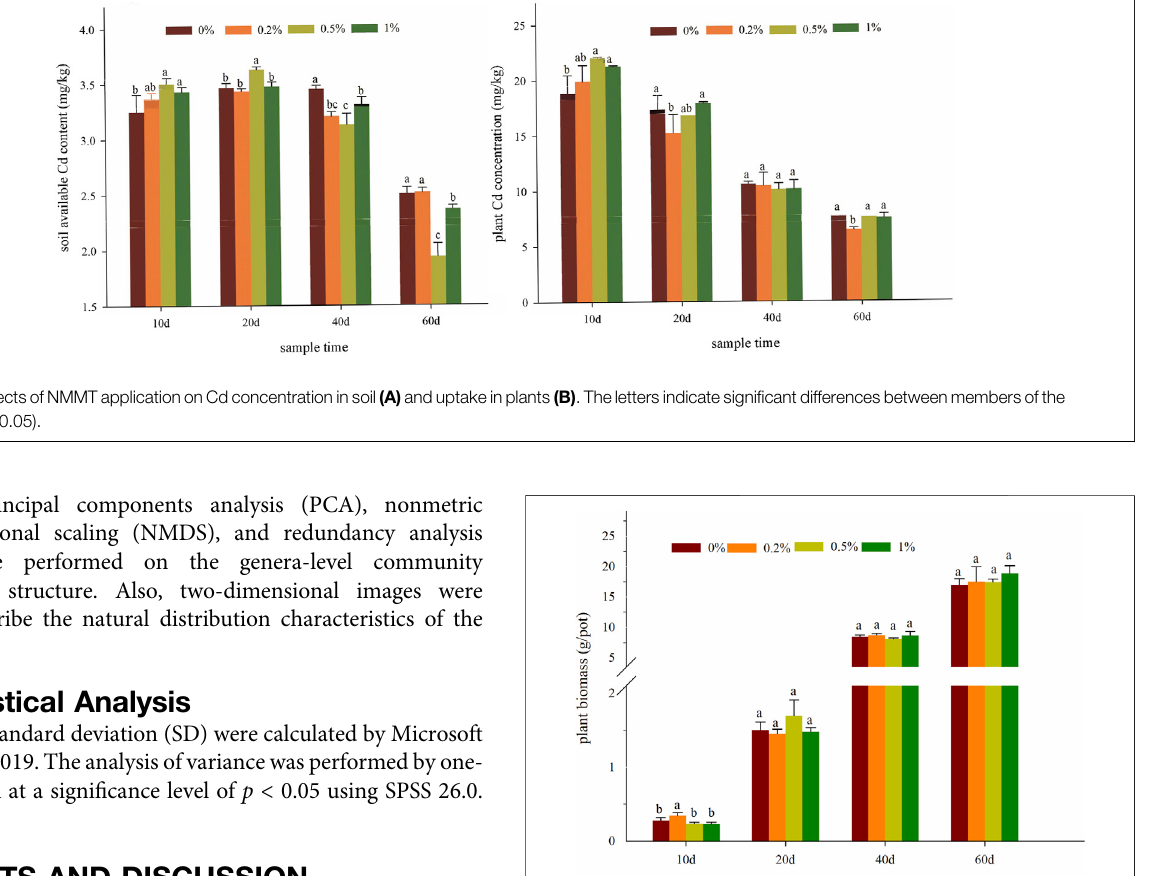
Frontiers in Environmental Science |